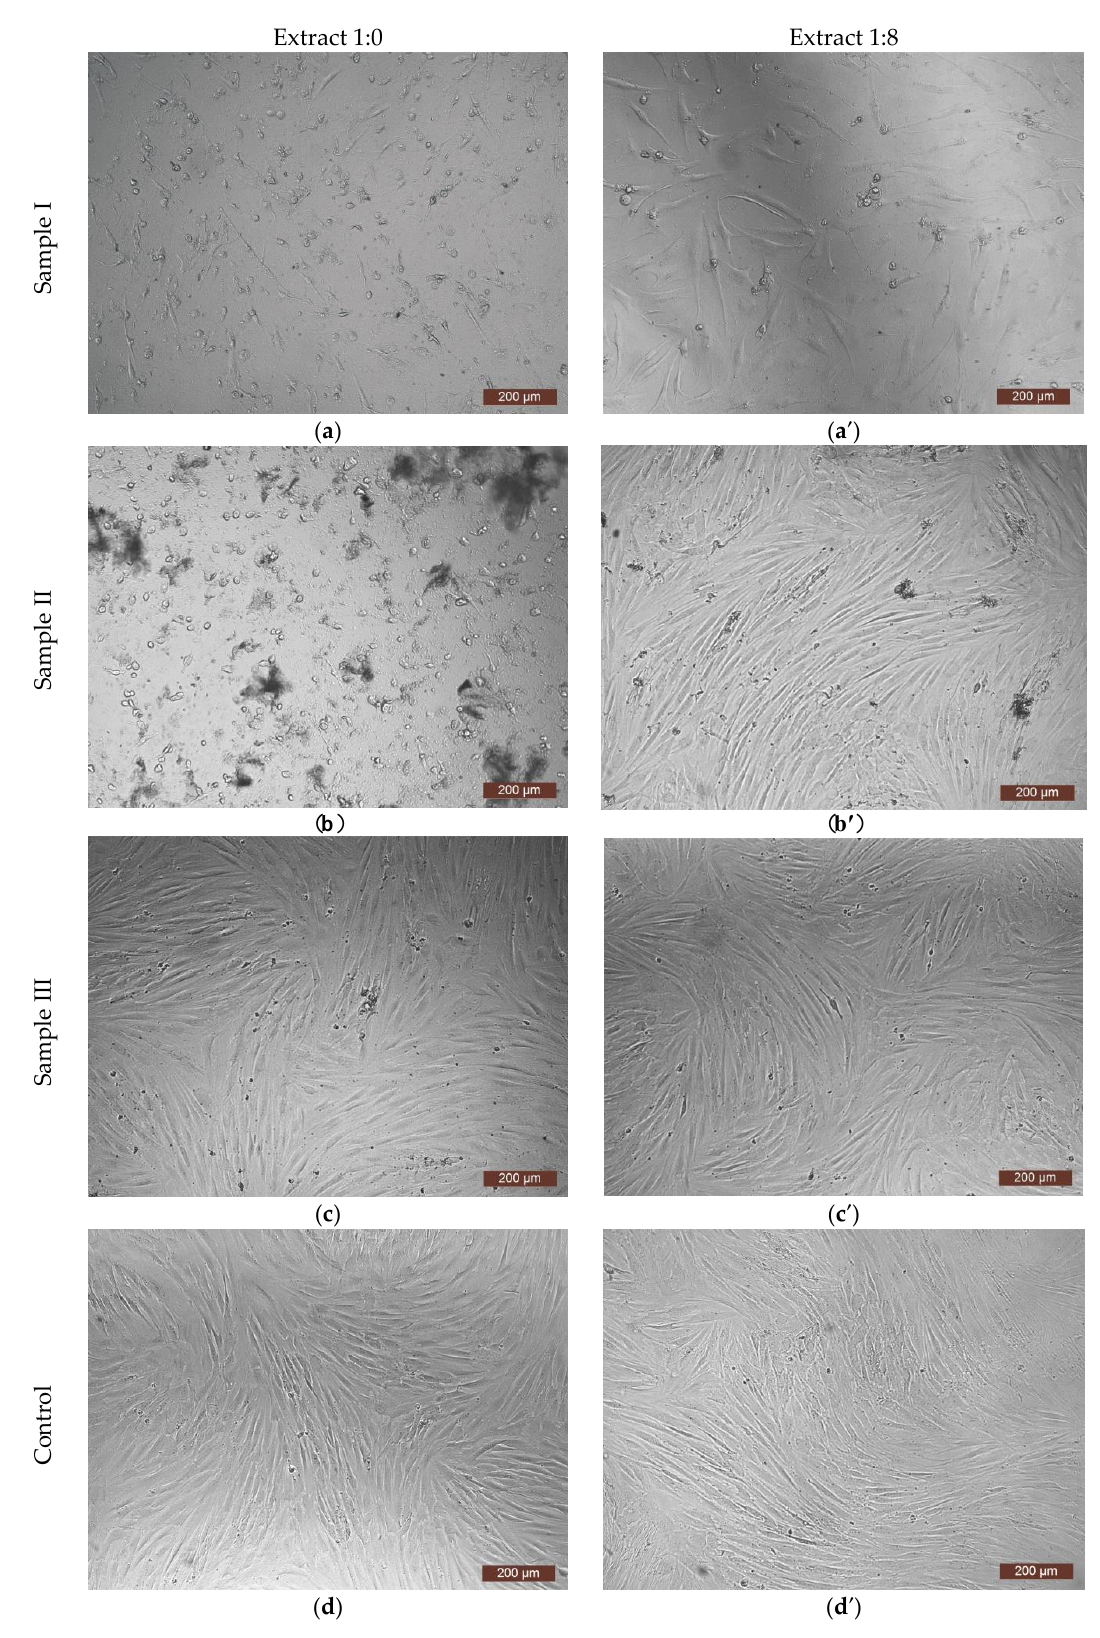
Figure 4. Representative photos, MTT test. ( a )—the extract 1:0 of an aqueous solution of acetic acid containing a dispersion of collagen and PAA copolymer synthesized at 60 ◦ C; ( a’ )—1:8 dilution of the ( a ); ( b )—the extract 1:0 of lyophilic-dried copolymer of collagen and PAA synthesized at 60 ◦